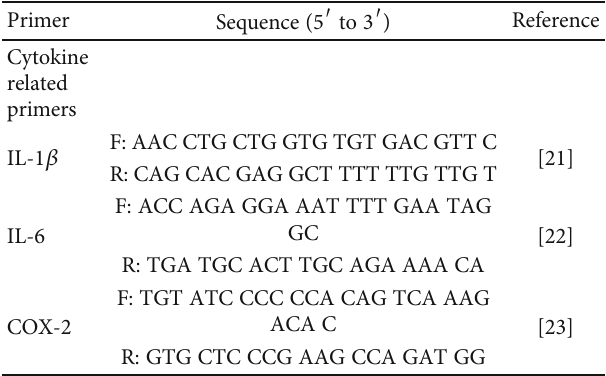
Table 5: Scoring table for disease activity index.